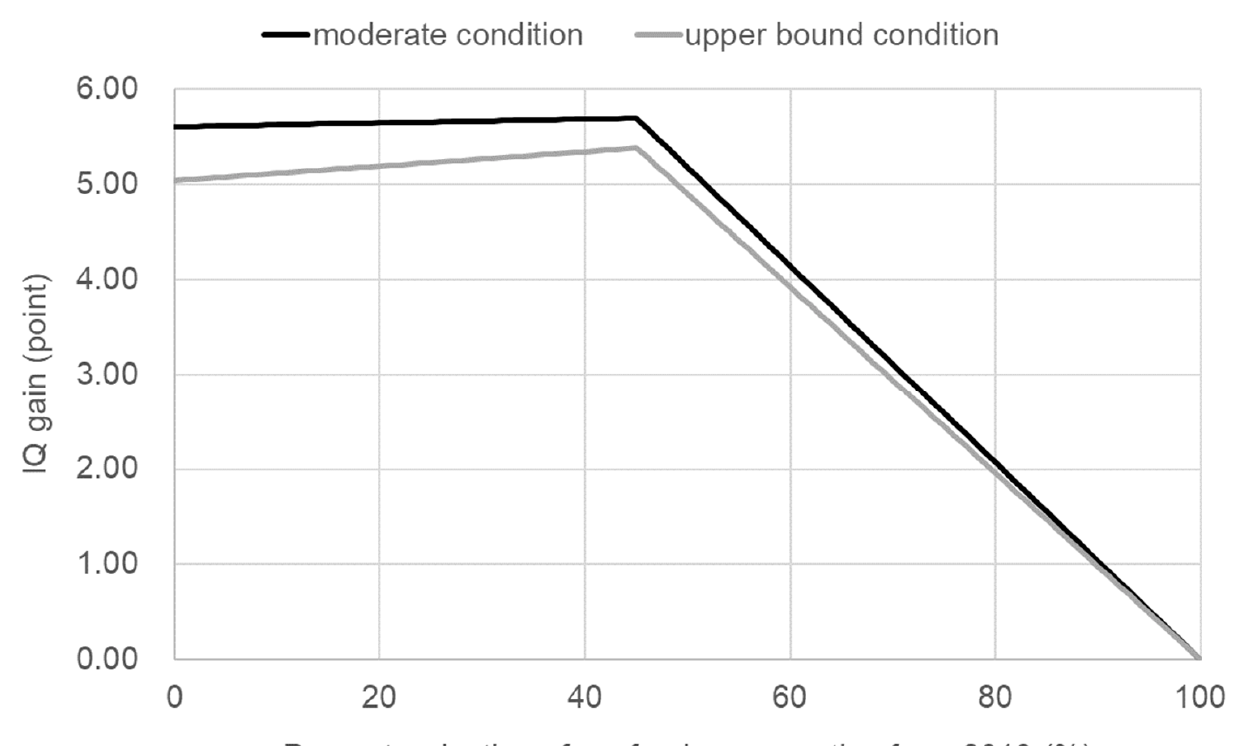
Figure 3. Change of IQ gain of infants according to the reduction of maternal seafood consump- tion.